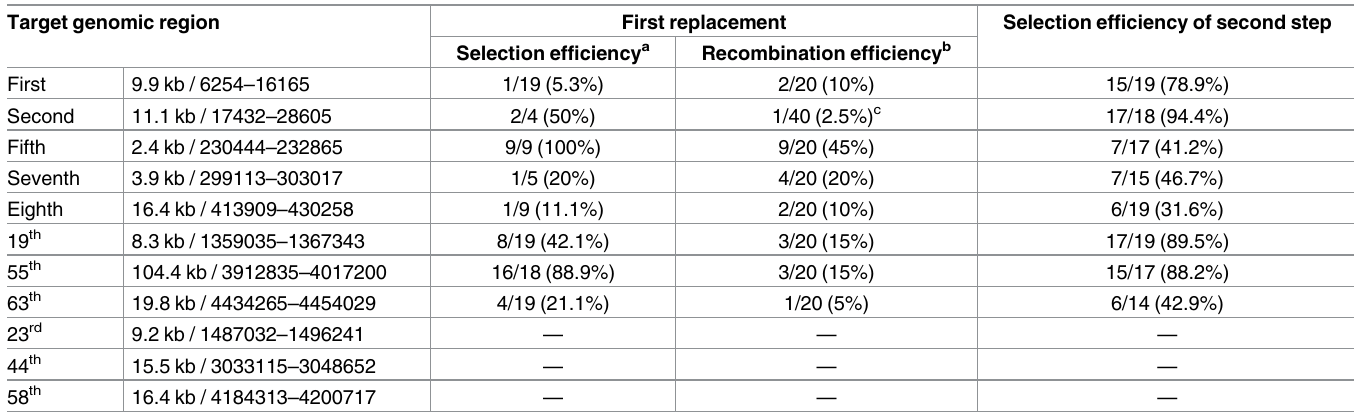
Table 1. Efficiency of pCNA/pSNK mediated deletions. Target genomic region